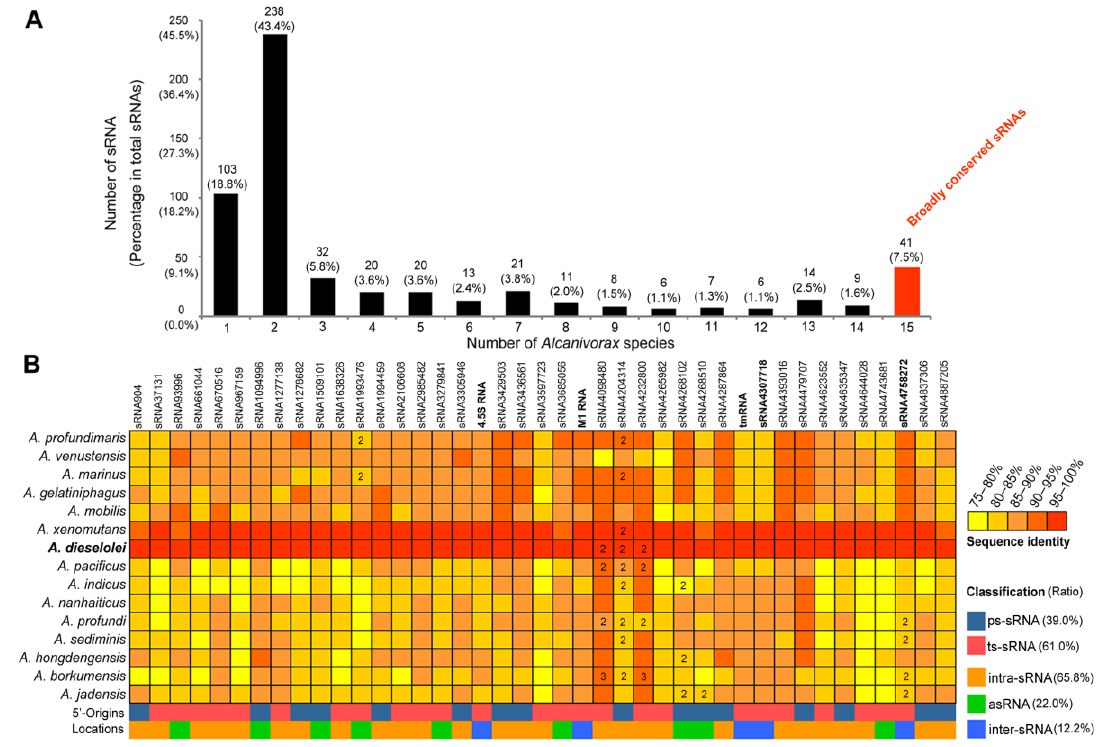
Figure 5. Distribution of sRNA homologs across different species of Alcanivorax . ( A ) The number (percentage) distribution of sRNA homologs across one ( A. dieselole i-specific) to all 15 (broadly conserved) species of Alcanivorax . The bar with broadly conserved sRNAs is marked in red. ( B ) The sequence identity distribution of the 41 conserved sRNAs across different Alcanivorax species and their classifications in the reference strain B-5. The different sequence identities are shown using color gradients from yellow to red. The number (2 or 3) in the grid represents the copy number of the related sRNA in corresponding species, and the average identity of multiple copies is shown. The classifications of sRNAs are also displayed by distinct